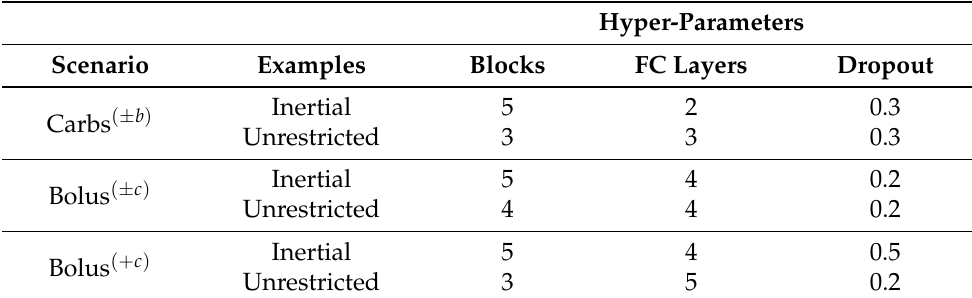
Table 10. Tuned hyper-parameters for the N-BEATS-based